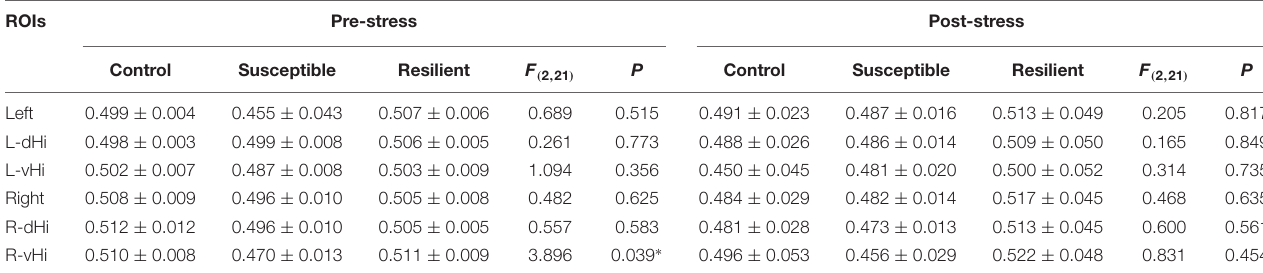
TABLE 1 | Group comparisons of pre- and post-stress hippocampal FA values.